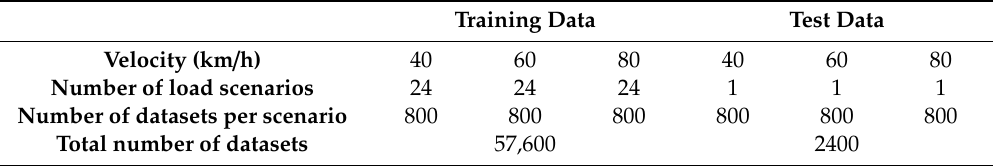
Table 5. The number of training and test datasets.